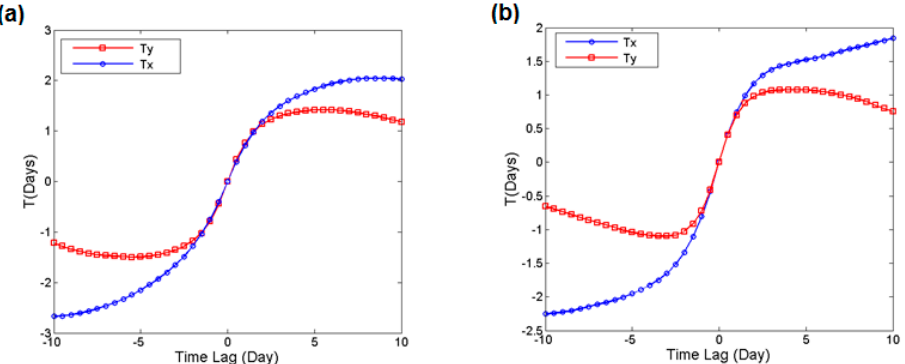
Figure 10. Lagrangian statistics (diffusivity) calculated for the entire Adriatic basin after removal of the mean Eulerian circulation. Statistics are shown versus time lags ranging between − 10 and 10 days for numerical particles in 2007 ( a ) and 2008 ( b ). (Kxx and kyy show along and across basin diffusivity values respectively).